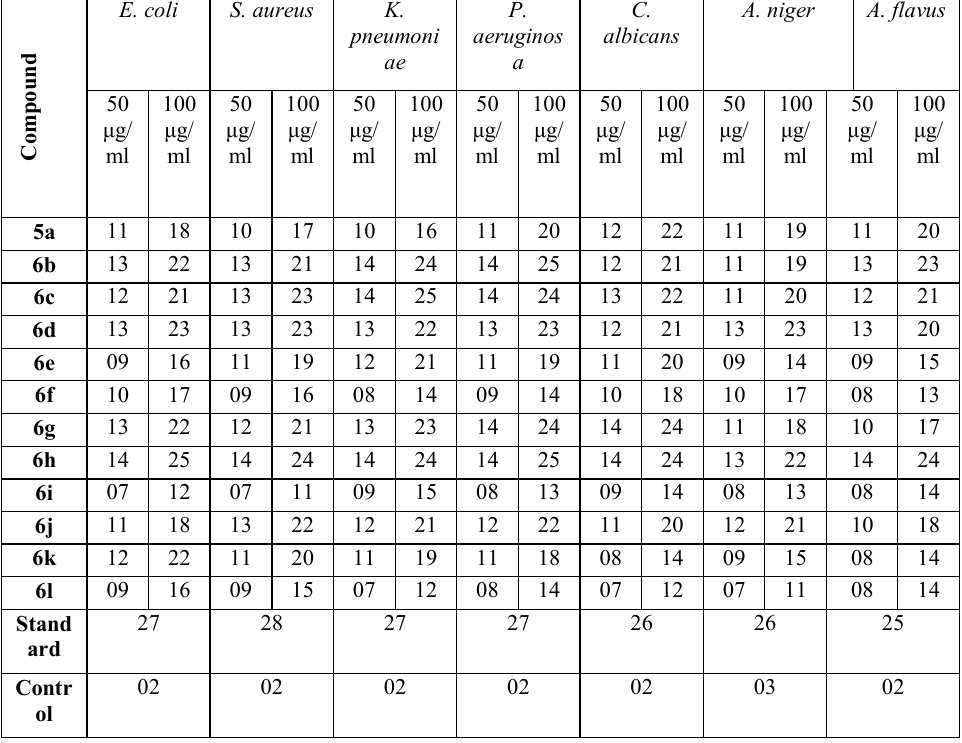
Table 1. Zone of inhibition (mm) of different